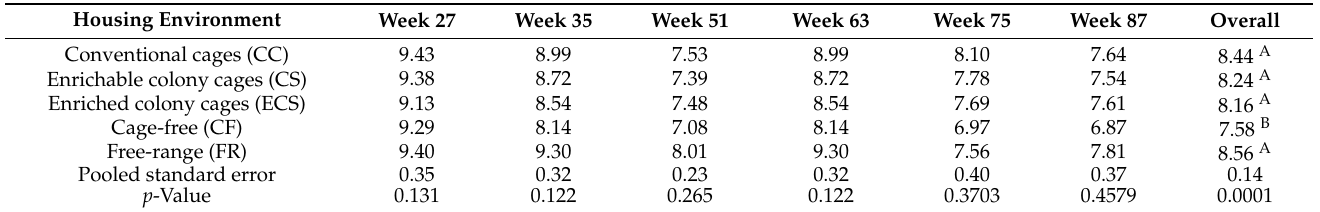
Table 5. The effect of housing environment on albumen height (mm) of brown egg layers by week and overall.